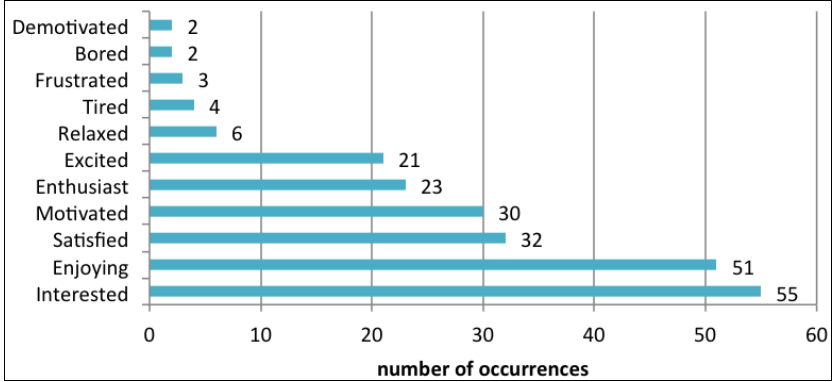
Figure 10. Adjectives describing players’